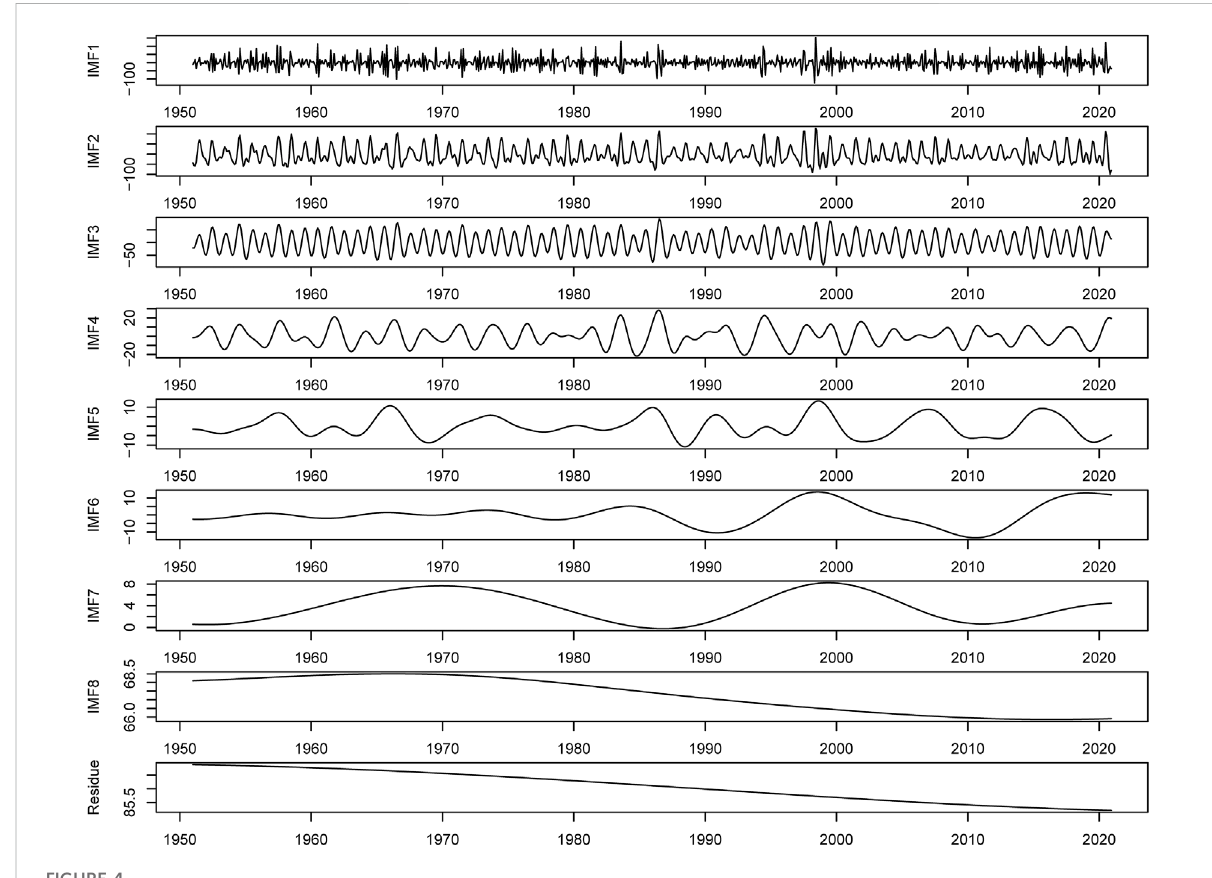
FIGURE 4 The decomposition results of the precipitation series at Kunming station by EEMD.